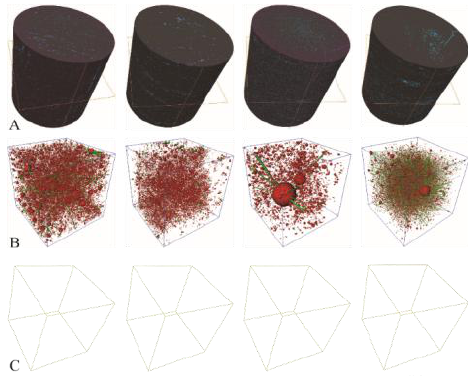
Figure 3—3D digital models, ball-and-stick models, and interconnected pore models of coal samples based on X-ray CT before CO 2 treatment.